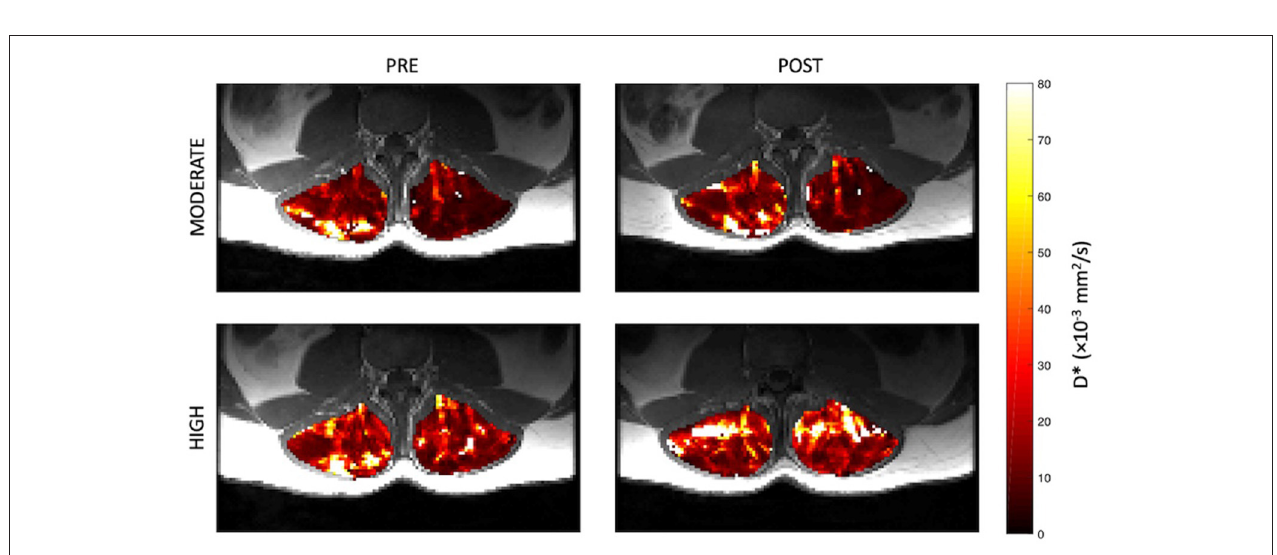
FIGURE 5 | Representative parameter maps of pseudo-diffusion coefficient, D*, before and after both moderate (top) and high (bottom) intensity resisted lumbar extension